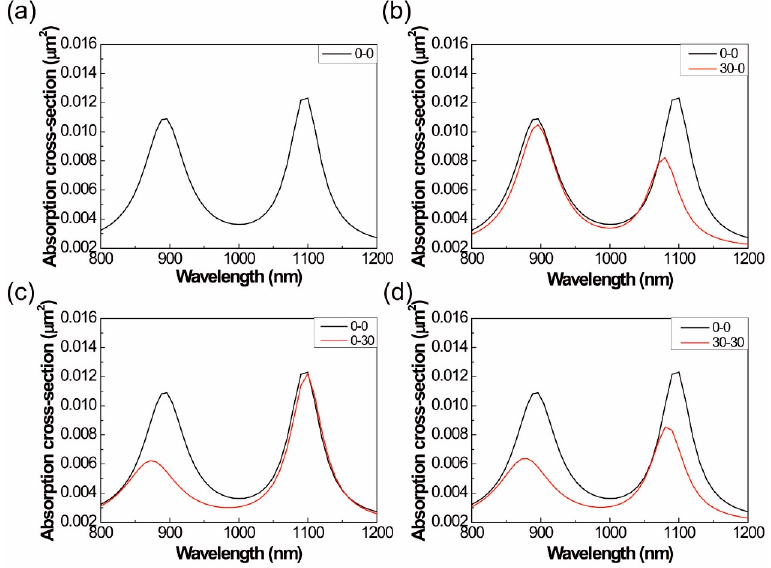
Figure 4. ( a ) Absorption cross-section spectrum of the 2D plasmonic ruler without upper nanoblock movement, ( Δ x = 0 nm and Δ y = 0 nm), denoted by (0-0). Two absorption peaks are observed at 882.2 nm (M1) and 1081.3 nm (M2). Absorption cross-section spectra with respect to Δ x (nm) and Δ y (nm) values of ( b ) 30 nm, 0 nm (30-0), ( c ) 0 nm, 30 nm (0-30), and ( d ) 30 nm, 30 nm (30-30). The black line indicates a reference absorption spectrum (0-0) and the red line indicates the absorption spectrum of the cavity with a moved upper block.